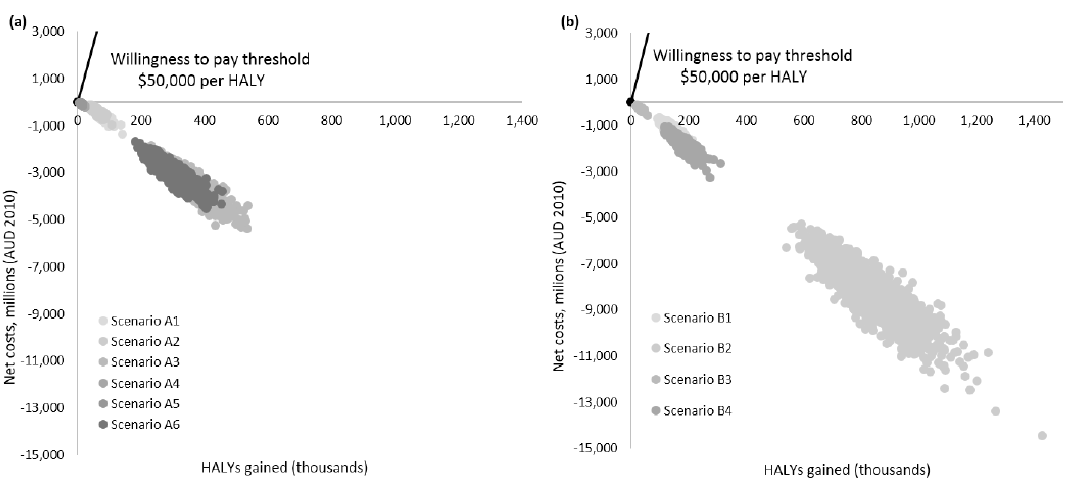
Figure 2. Cost-effectiveness planes of the ( a ) package size cap and ( b ) energy reduction interventions and associated scenarios.